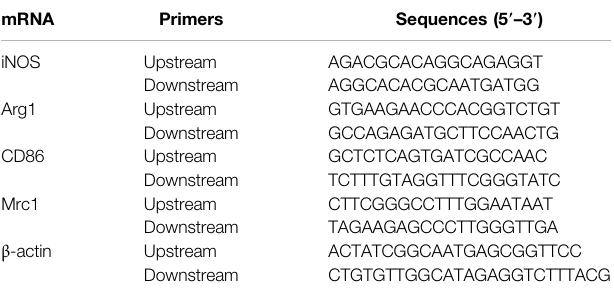
FIGURE 1 | Effect of MET on the survival rate of PQ-poisoned rats. MET atdosesof15,25and35 mg/kgwasusedtotreatPQ-poisonedrats,andthe survival of rats in each group was recorded ( n = 10). Statistical analysis between groups were conducted, # p < 0.05, ** p < 0.01, *** p <